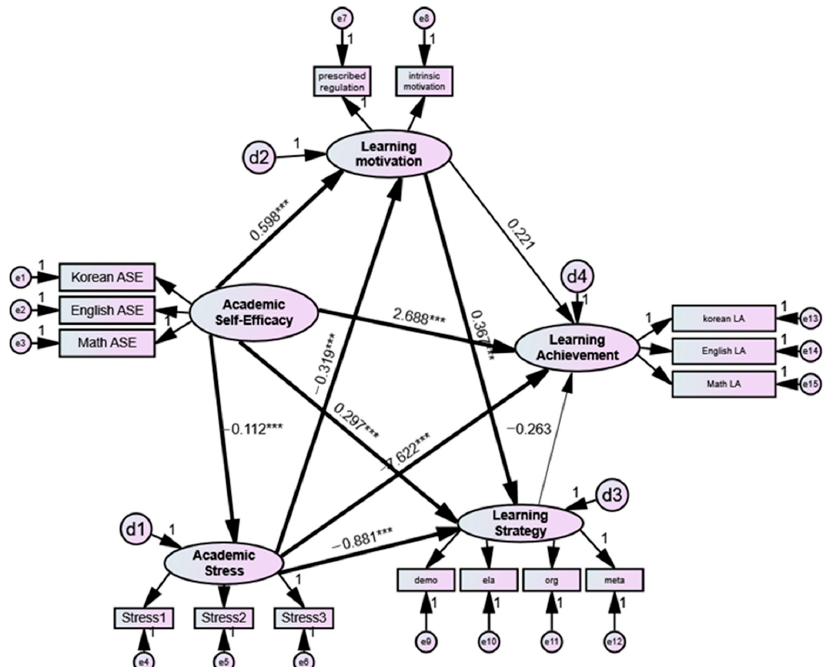
Figure 3. High school model showing academic stress, learning motivation, and learning strategy as mediating variables in the relationship between academic self-efficacy and academic ment. Note : e = measurement error; d = structural error; ASE = academic self-efficacy; LA = learning achievement; stress1 = anxiety stress; stress2 = relationship stress; stress3 = competence stress; demo = demonstration; ela = elaboration; org = organization; and meta = meta-cognition. *** p < 0.001.